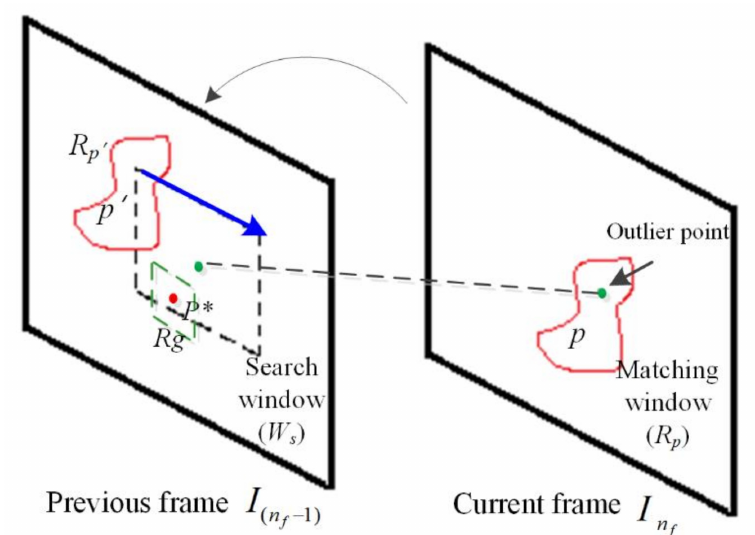
Figure 5. Profile of matching operation. The green point is an outlier positioned at the current frame corresponding to the previous frame. The red region is the matching window ( R p ) obtained in the SLIC segmentation and merging result. The rectangular region presented in the previous frame is the specified search window ( W s ) with a size of 11 × 11. The green region denotes Rg region with a size of 3 ×